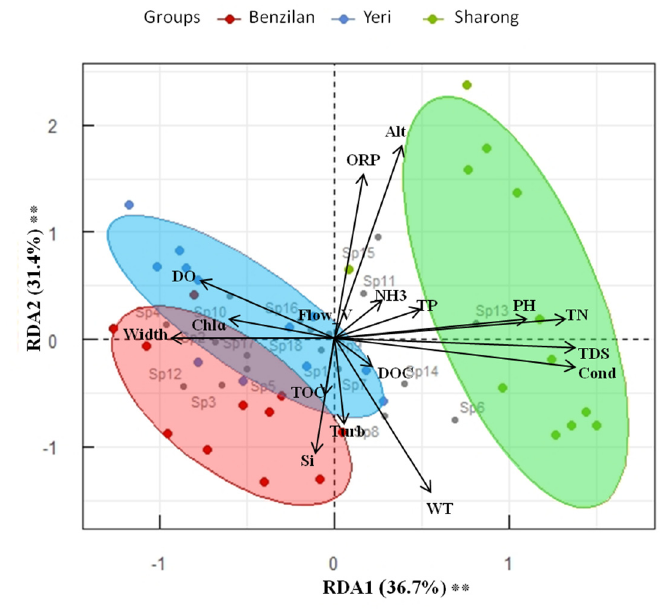
Figure 4. RDA model biplot based on community and environmental variable matrices. The environmental variables were used as explanatory factors ( n = 17). The significance of the model, axes, and factors was determined by ANOVA (1000 permutations; α = 0.05). Stars next to percentages stand for the level of significance: according to the code: (*) 0.05 ≤ p -values < 0.01; (**) 0.01 ≤ p -values < 0.001; (***) p -values ≤ 0.001.